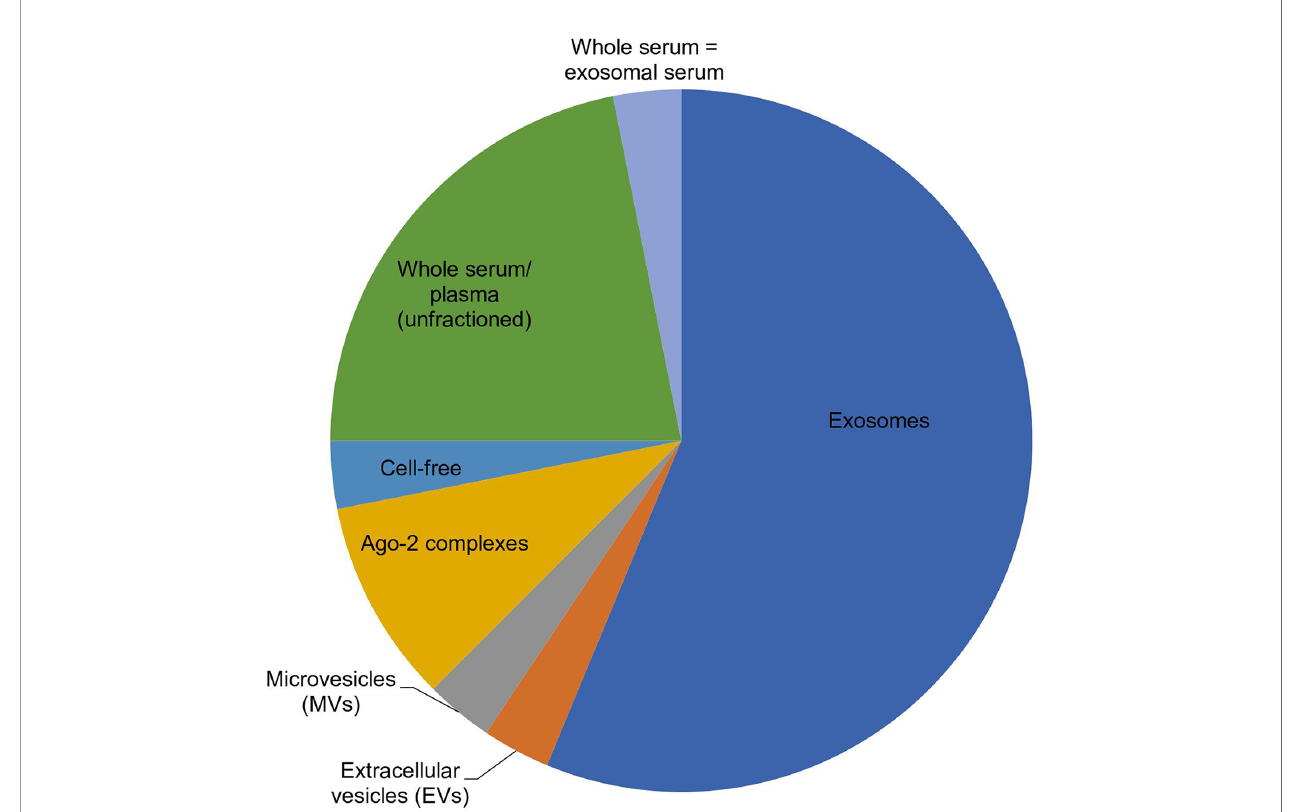
FIGURE 1 | Pie chart showing the distribution of 32 selected articles in which a miRNA origin was preferred, according to their comparative study fi ndings. Out of 32 articles, 18 chose exosomes, 1 chose EVs, 1 chose MVs, 3 chose Ago-2 complexes, 1 chose cell-free, 7 chose unfractioned, and 1 showed similar expression between whole serum versus exosomes, as the best origin for miRNAs used in biomarker